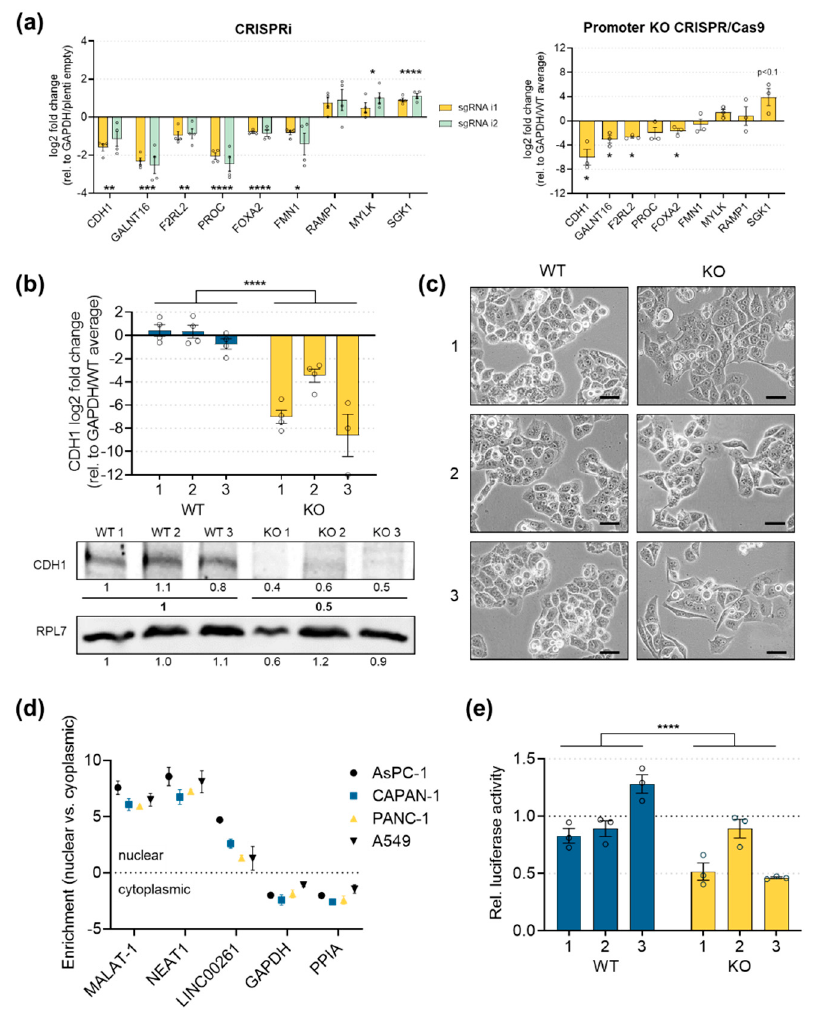
Figure 6. LINC00261 regulated E-cadherin expression. ( a ) The qPCR analysis of the genes commonly deregulated in both CRISPR systems, as shown in Figure 5e, in addition to FOXA2 (* p < 0.05, ** p < 0.01, *** p < 0.001, **** p < 0.0001, two-way ANOVA, unpaired t -test). ( b ) Expression of E-cadherin mRNA (upper panel) and protein levels (lower panel) in three wild-type and three promoter knockout clones (**** p < 0.0001, two-way ANOVA). ( c ) Brightfield images of wild-type and LINC00261 promoter knockout clones (20 × objective, scale bar = 50 µ m). ( d ) Cellular fractionation in lung cancer and pancreatic cancer cell lines, highlighting nuclear enrichment of LINC00261. ( e ) Relative luciferase activity of the CDH1 gene promoter constructs normalized to the pGL3-vector with a minimal cytomegalovirus (CMV) promotor (pGL3-minCMV). The average of the relative luciferase activity in wild-type clones was set to 1.0 (**** p < 0.0001, two-way ANOVA).